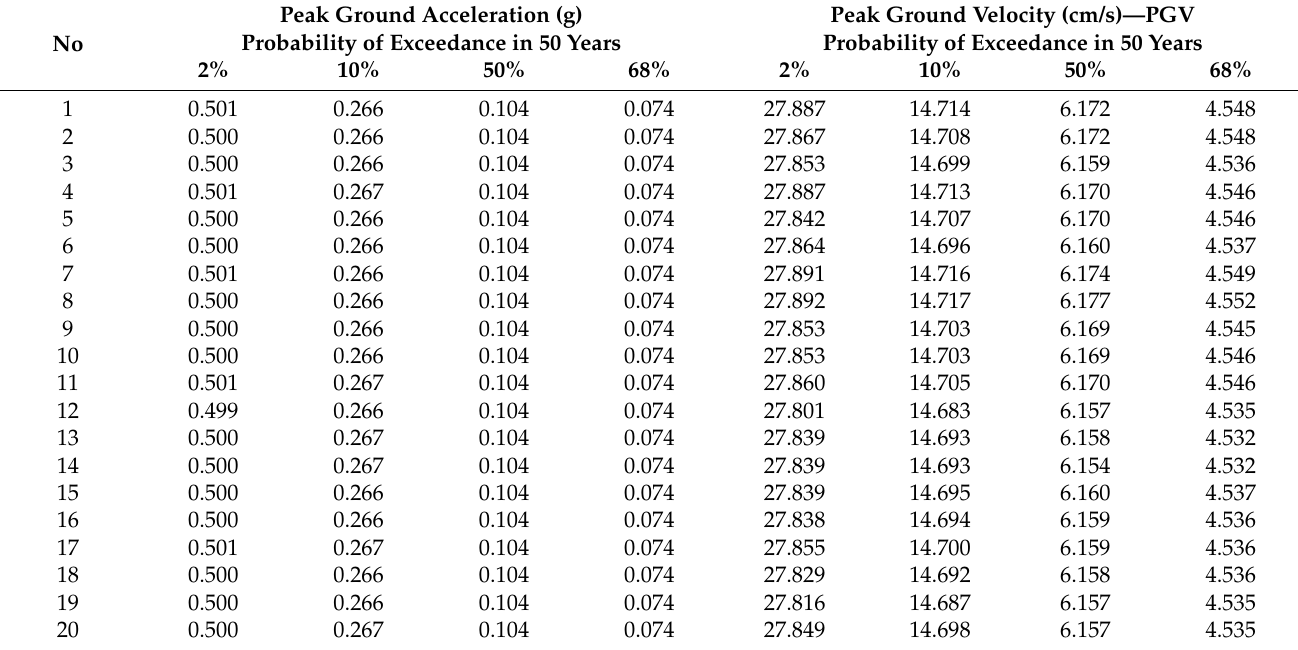
Table 2. PGA and PGV values obtained for the different probabilities of